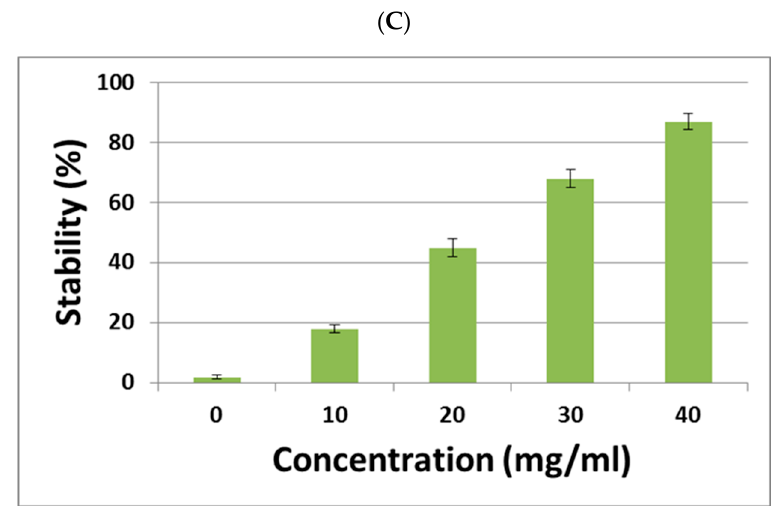
Figure 3. Laser manipulation of a pair of epithelial cells (NMuMG); ( A ) 5 s or ( B ) 300 s in the presence of dextran (40 mg/mL): Spatio-temporal diagram illustrating the process of manipulation (Approach, Contact or Separation ( A ) or Adhesion ( B )). ( C ) The probability that stable cell–cell contact is maintained through optical transportation for the distance of ca. 5 mm, i.e., the percentage of experimental runs to obtain the result as exemplified in ( B ), where the result as in ( A ) was counted as a failure. Error bars represent the standard error of the mean calculated from three independent measurements.